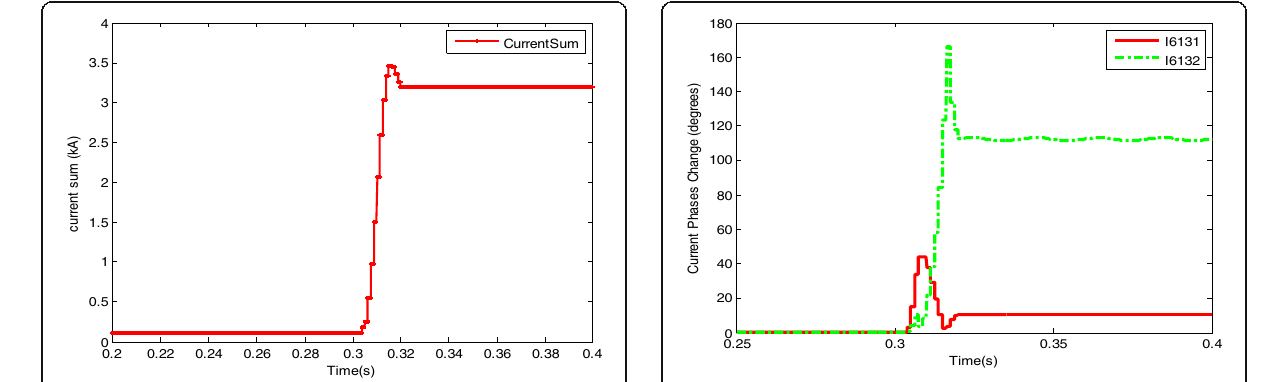
Fig. 9 Current phase changes of fault power path (F3 and